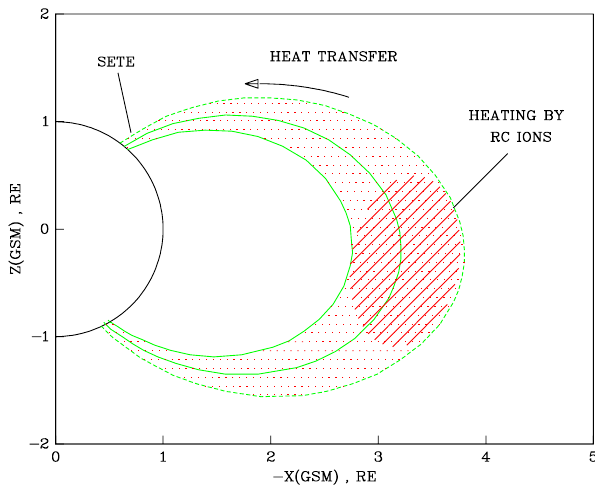
Fig. 1. Topology of magnetic field lines threading the inner- magnetospheric heating region. A projection onto the x–z plane of a geocentric solar-magnetospheric (GSM) coordinate system is shown. The field lines were calculated for 05.3 UT on 5 Septem- ber 1982 using the Tsyganenko model T 96-1. The footpoints are located at 53.5, 56.6 and 58.4 invariant latitude, respectively. They apply to the fifth subaural electron temperature enhancement shown in Fig. 2. RC stands for ring current and SET E for subauroral elec- tron temperature